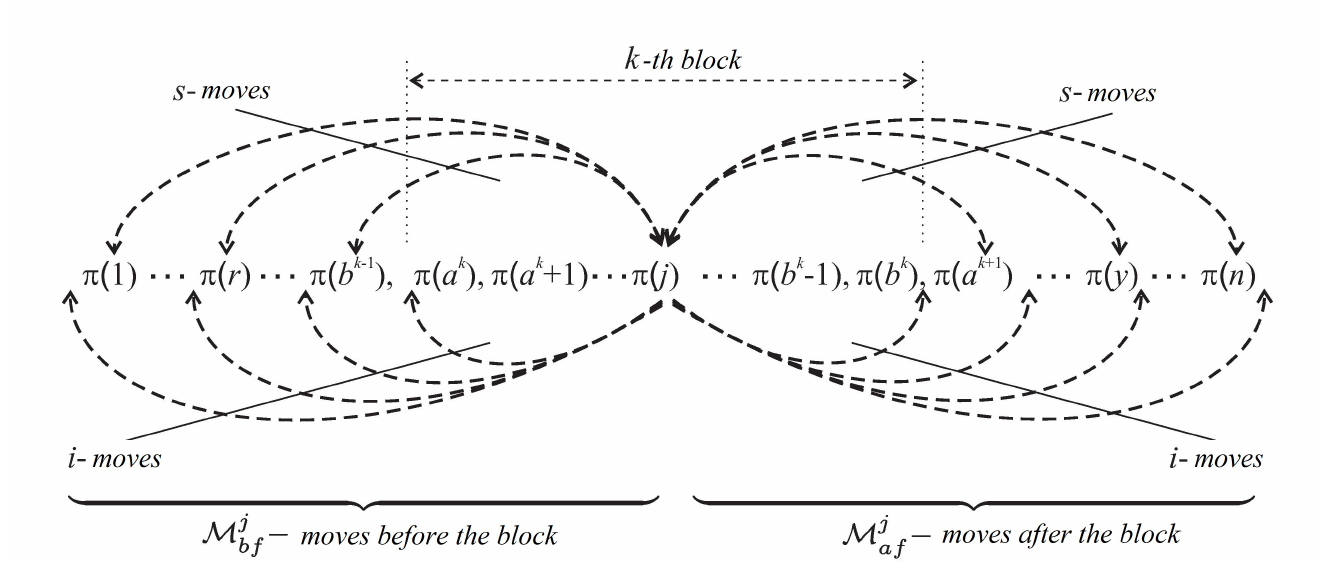
Figure 1. Task moves π ( j ) that can bring improvement goal function